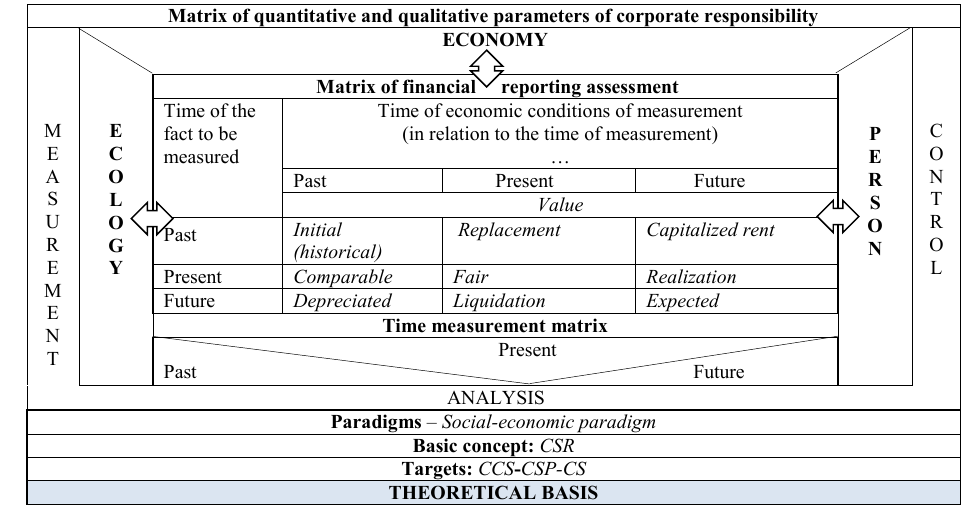
Figure 1 Matrix of quantitative and qualitative parameters of corporate responsibility (by the